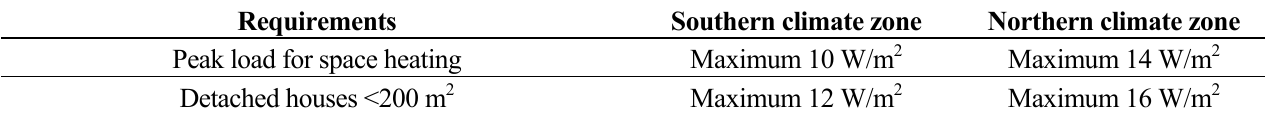
Table 1. Summary of the key elements of the voluntary Swedish Passive House criteria, version 2008:1, residential